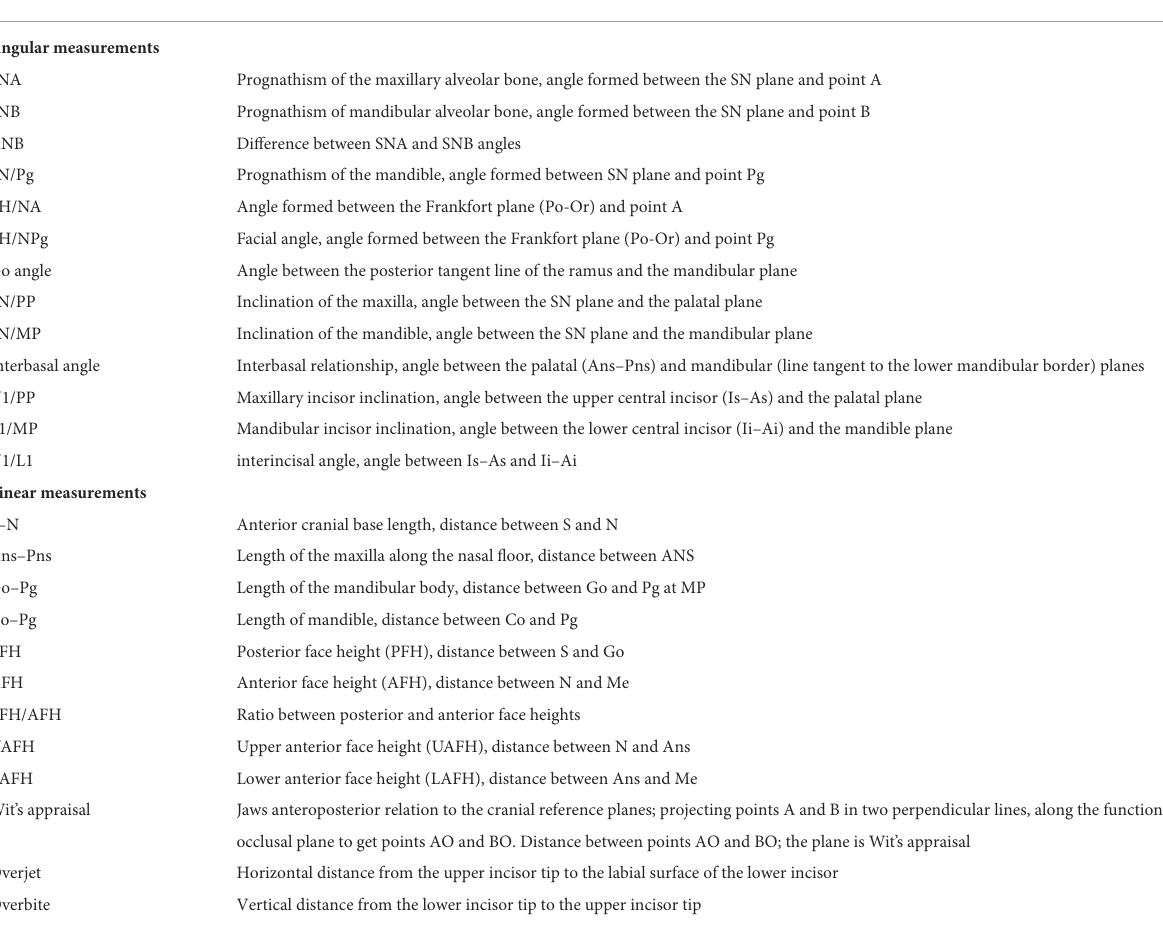
TABLE 2 The angular and linear skeletal measurements and their